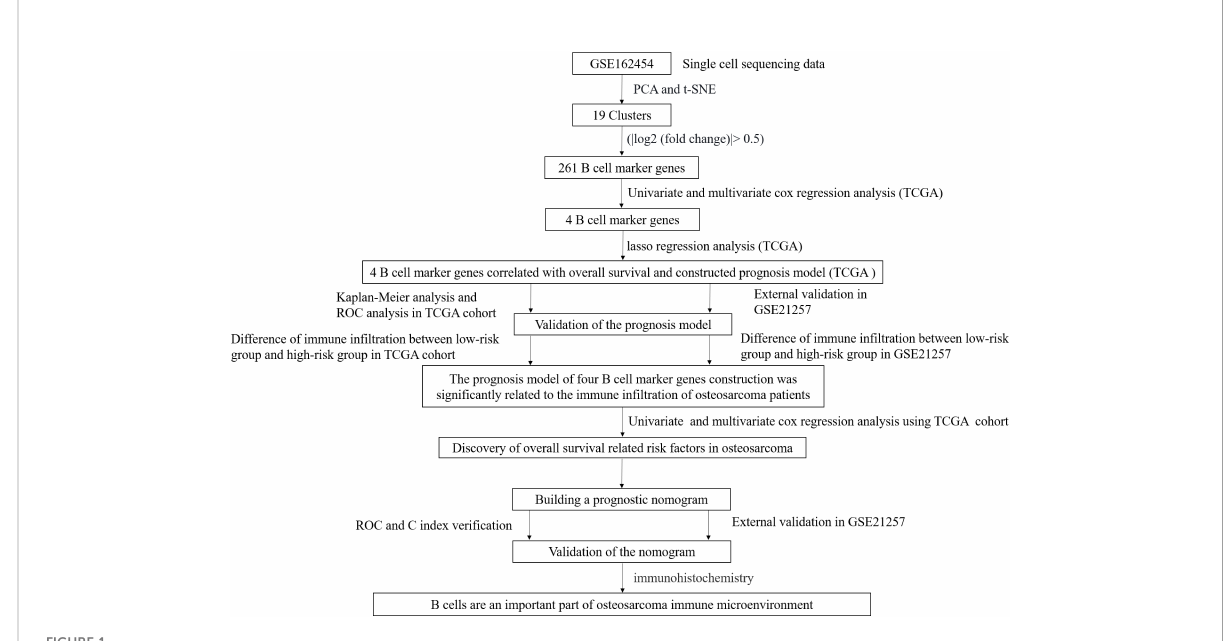
FIGURE 1 The fl ow chart describes the research idea and content of this